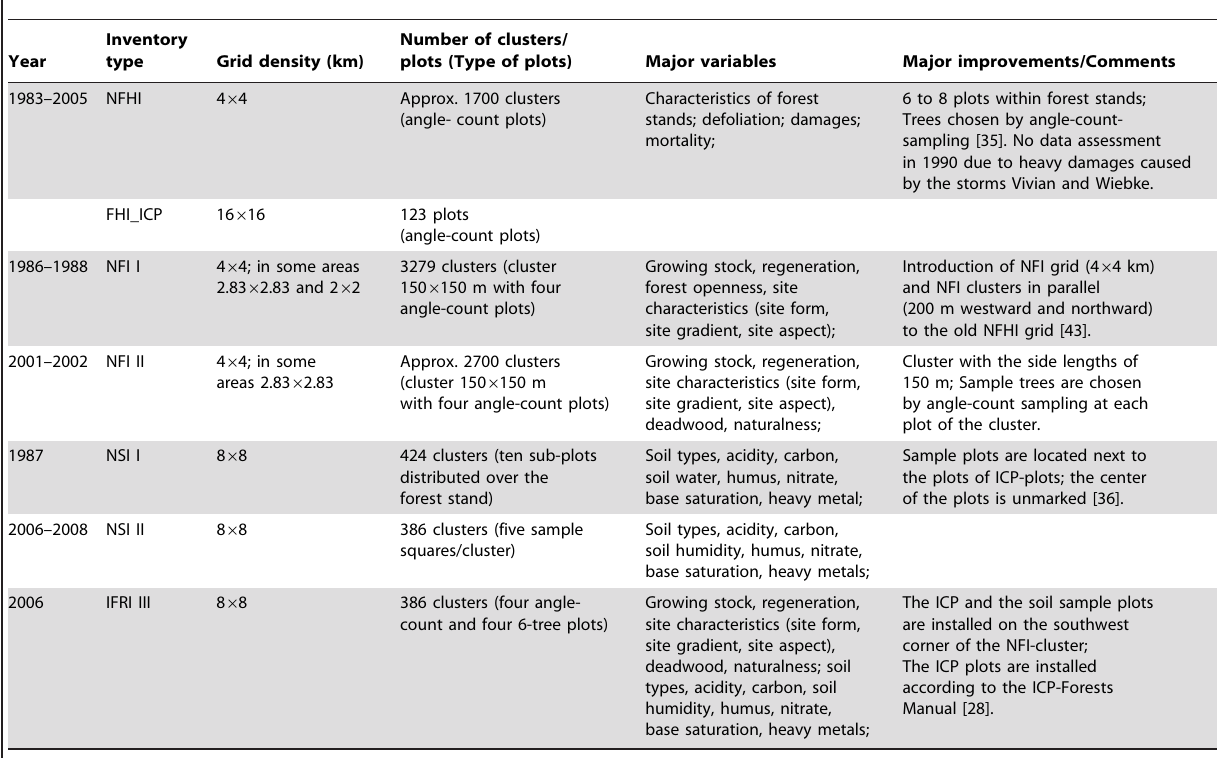
Table 2. Historical development of large-scale forest resource inventory in Bavaria,